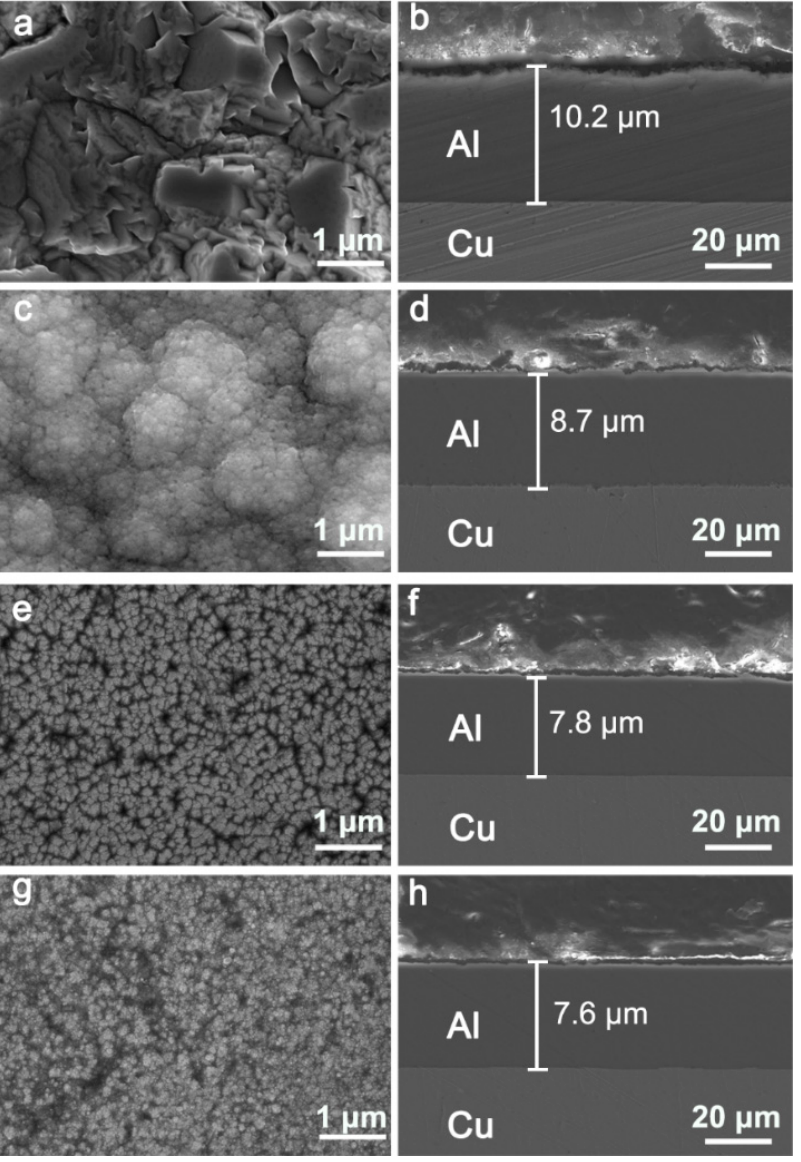
Figure 4. Surface and cross-sectional morphology of Al coatings on Cu substrate electrodeposition at 10 mA/cm 2 for 30 min from AlCl 3 -EMIC ionic liquids containing ( a , b ) no and 6 mM of ( c , d ) 2-cyanopyridine, ( e , f ) 3-cyanopyridine, and ( g , h ) 4-cyanopyridine. ( a , c , e , g ) are the corresponding SEM surface images of coated samples at a 20,000× magnification, and ( b , d , f , h ) are the corresponding cross-sectional images of the coated samples at a 1000× magnification.